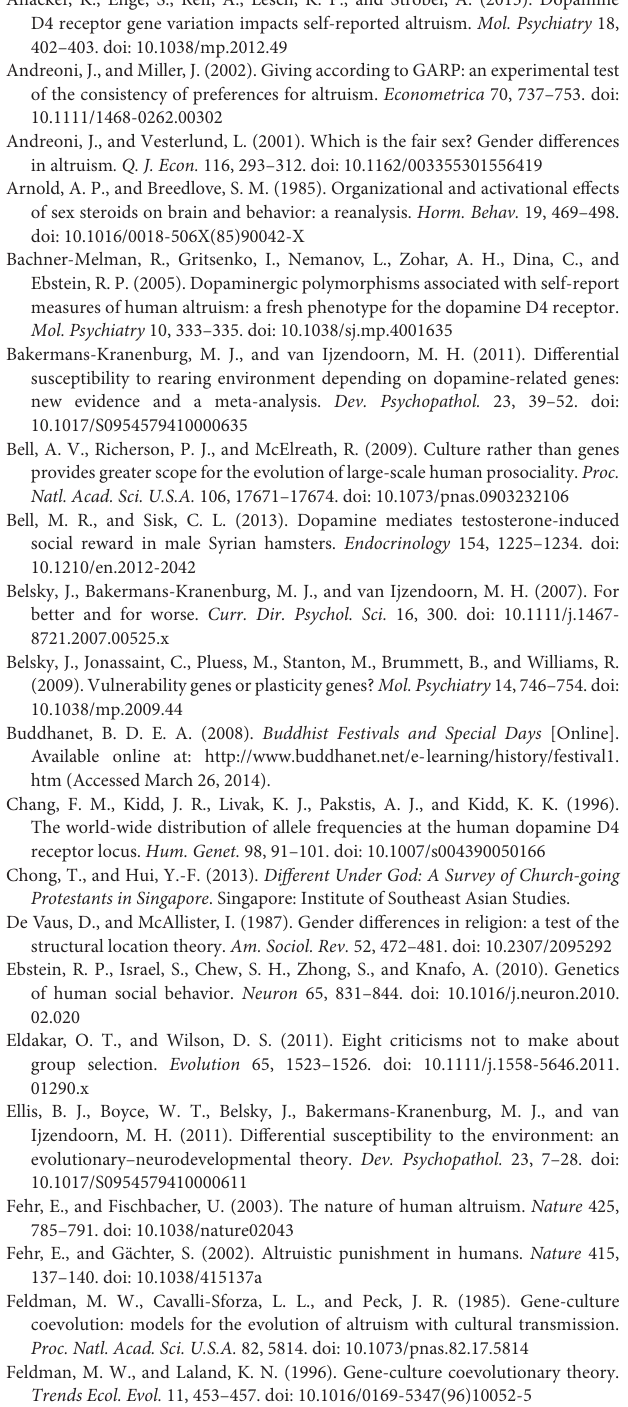
in the Female subgroup). (A) Shows Selfish deviation, (B) shows Efficient deviation, and (C) shows Fair deviation. The blue bars are No religion group, red bars are the Christian group, and green bars are the B-T group. Error bars are